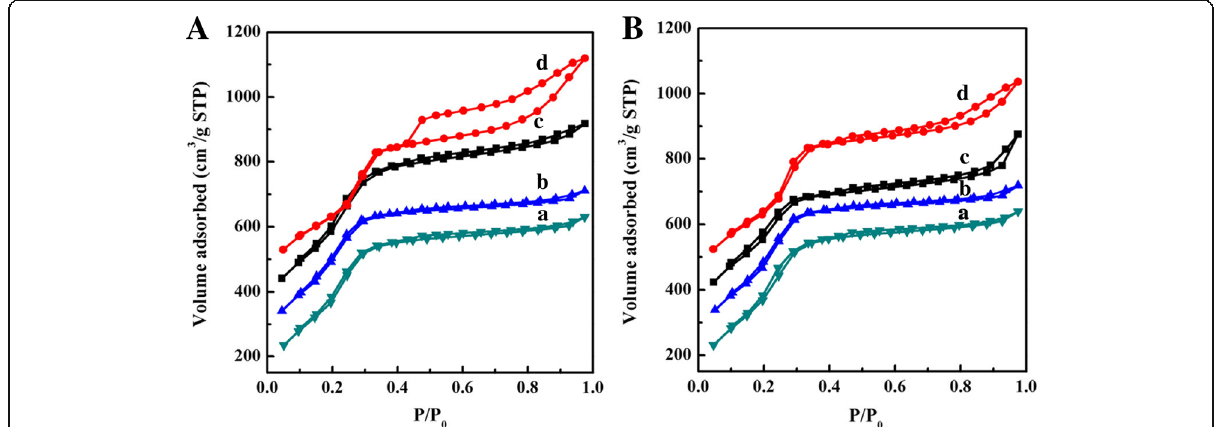
Fig. 1 The N 2 adsorption – desorption isotherms of the samples with different reaction times, A 40 min and B 60 min: a a-MCM-41, b o-MCM-41, c h-MCM-41, and d c-MCM-41. The isotherms shown in b , c , and d are offset by 100, 200, and 300 cm 3 /g, respectively